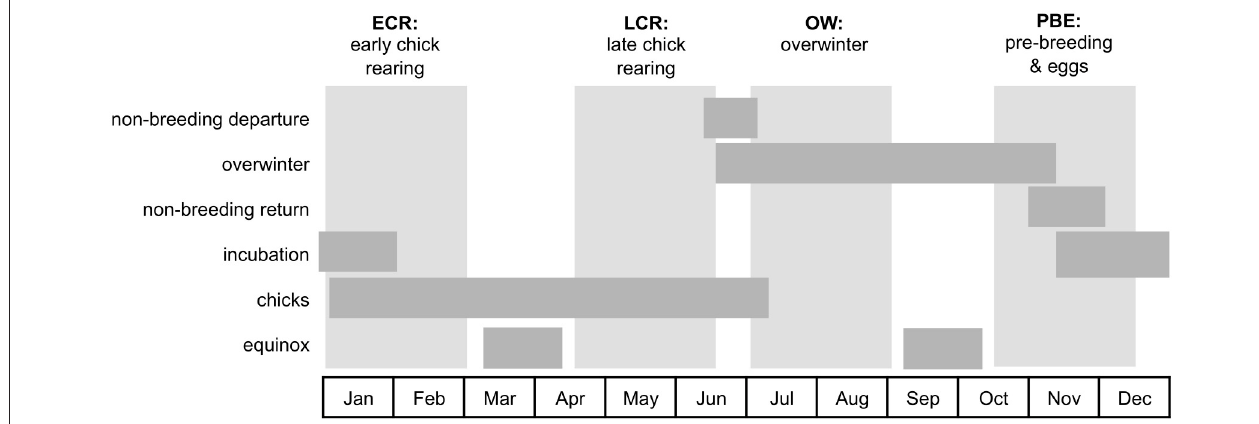
FIGURE 1 | The four periods of the annual cycle considered in analyses. Daily GLS locations of Laysan and black-footed albatross were divided into four 60-day periods (vertical light gray blocks) associated with different life history phases (horizontal dark gray bars). Early chick rearing (ECR) coincides with late incubation, peak hatch, and early chick rearing (01-Jan to 01-Mar). Late chick rearing (LCR) coincides with the end of chick rearing (05-Apr to 15-Jun). Overwinter (OW) occurs during the non-breeding season, when all birds have departed the colonies and are at overwintering areas at sea (01-Jul to 01-Sep). Pre-breeding and eggs (PBE) encompasses the end of non-breeding, the return of birds to the colonies for courtship, and the transition into egg laying and incubation (15-Oct to 15-Dec). The timing of reproductive events were derived from Arata et al. (2009) and Gutowsky et al. (2014b) and typically varies little among colonies or between species (at most by c. 2 weeks). Each period avoids overlap with the equinoxes and intervals of most intensive logger deployment and recovery (15-Dec to 01-Jan).